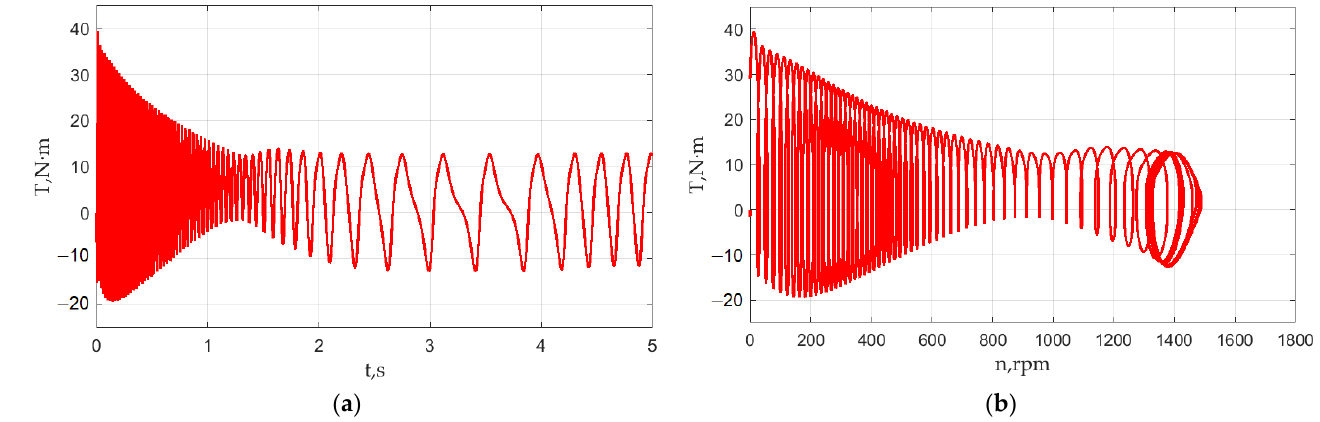
Figure 14. LSPMSM torque with fully closed valve, 372 V: ( a ) Torque versus time; ( b ) torque versus speed.